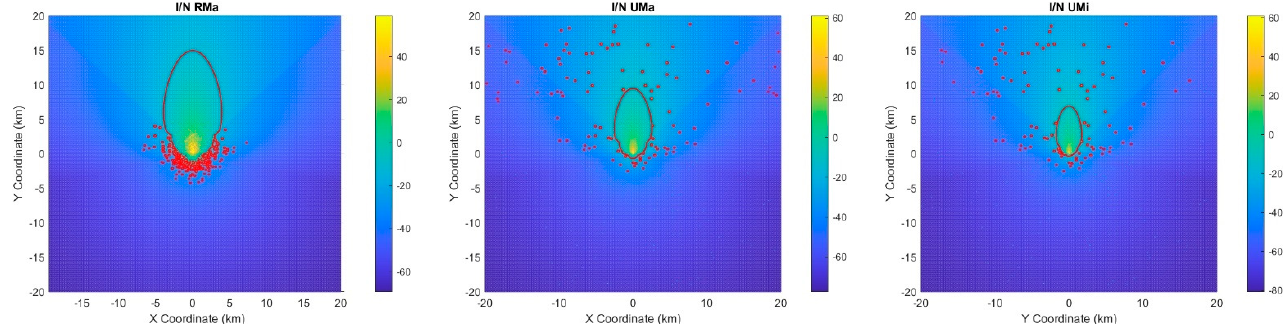
Figure 20. RMa, UMa, and UMi scenarios with an ES antenna elevation angle of 15° for a 4 × 4 antenna array.